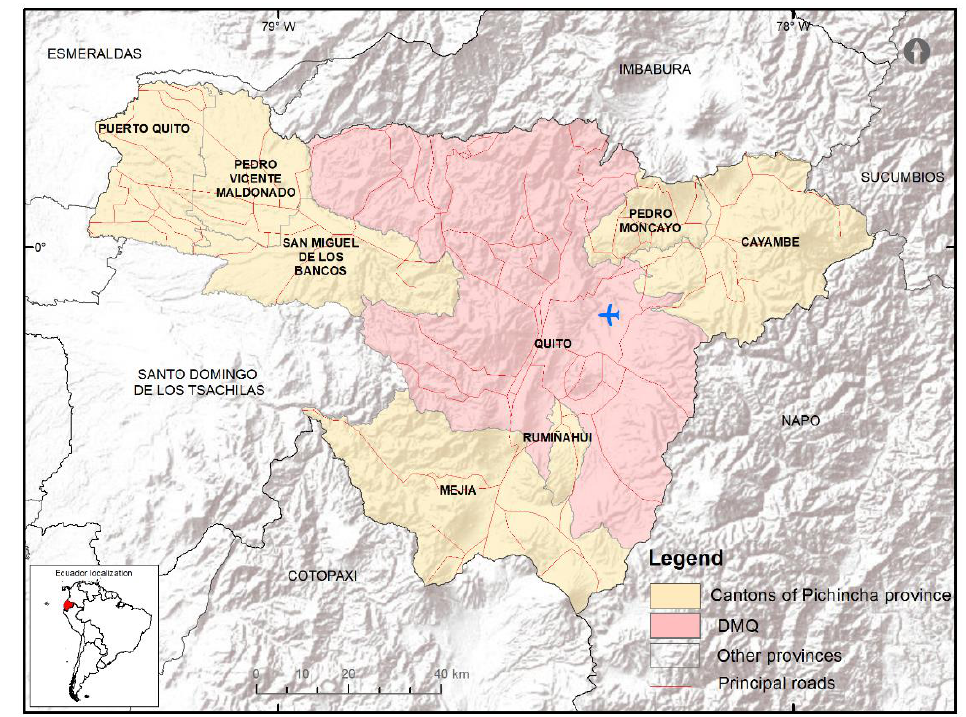
Figure 1. Spatial location of the Metropolitan District of Quito (DMQ) and its neighboring cantons in the Province of Pichincha.